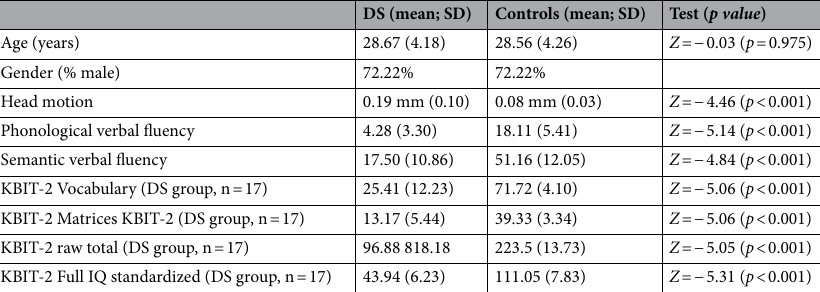
Table 1. Participant characteristics. Z Z score linked to the Mann–Whitney test, SD standard